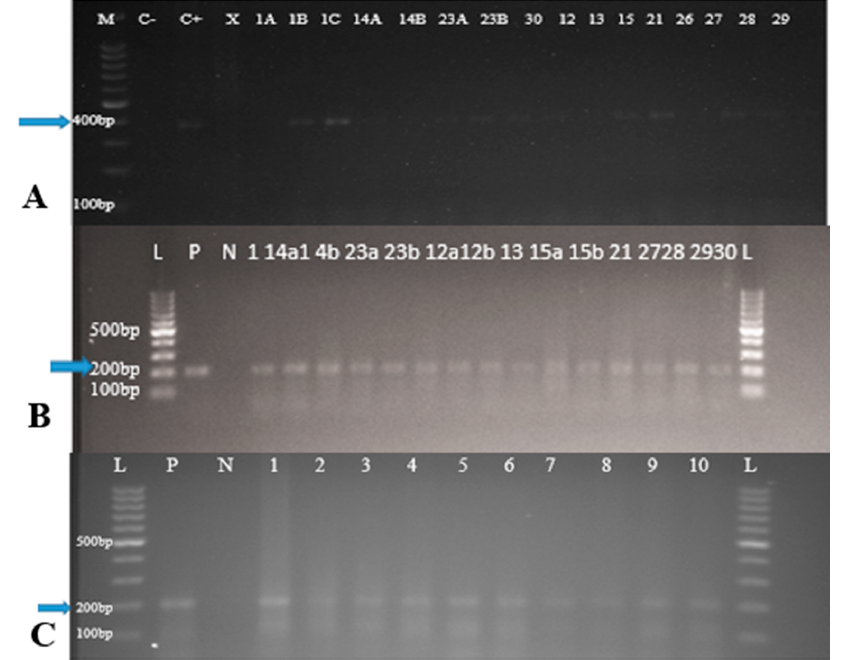
Table 2. Prevalence of the diagnostic test for detection of MTBC and MAC in wild boar and wild macaques.